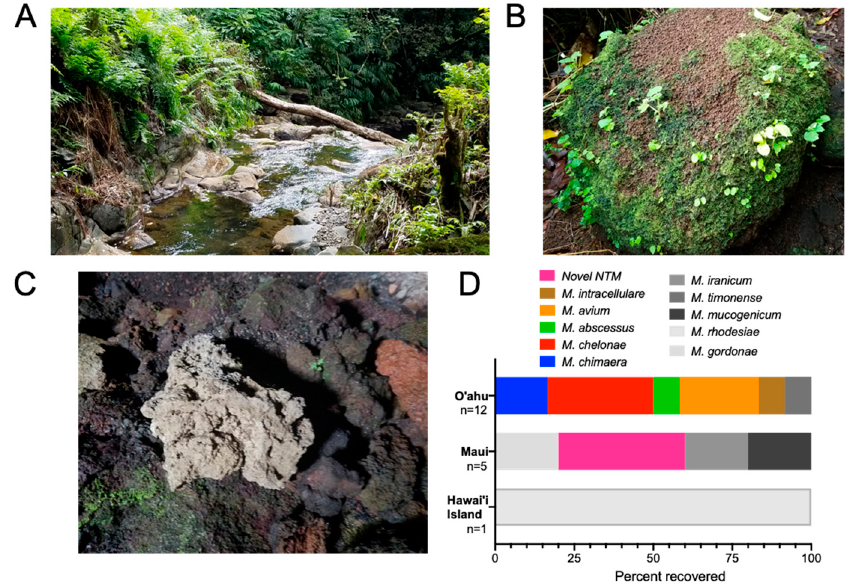
Figure 4. Natural areas of Hawai’i do not harbor significant NTM. ( A ) Representative image of freshwater streams that were sampled for NTM. In these locations, large rocks or boulders lodged in